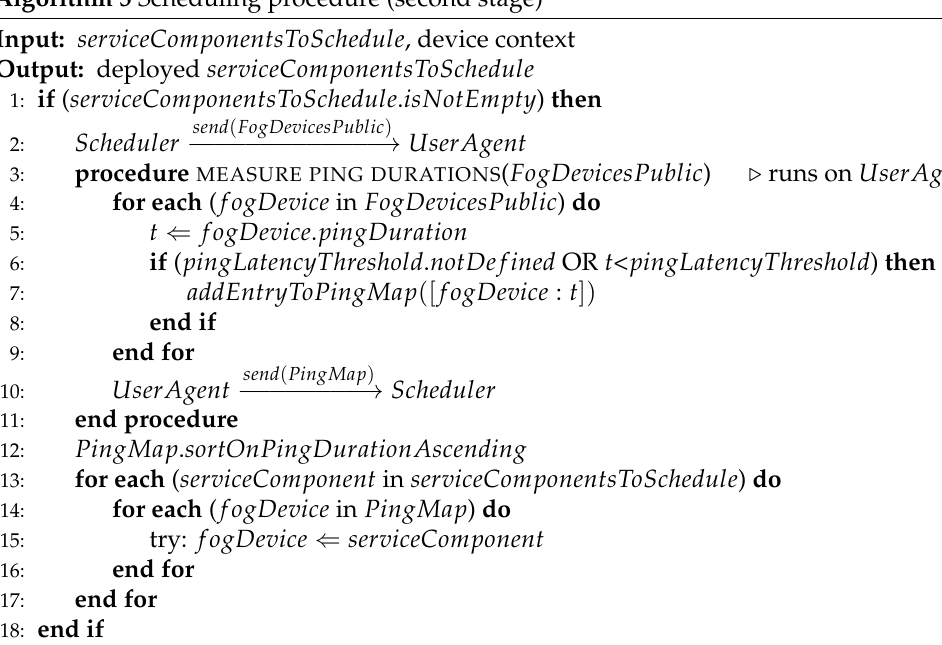
Algorithm 5 Scheduling procedure (second